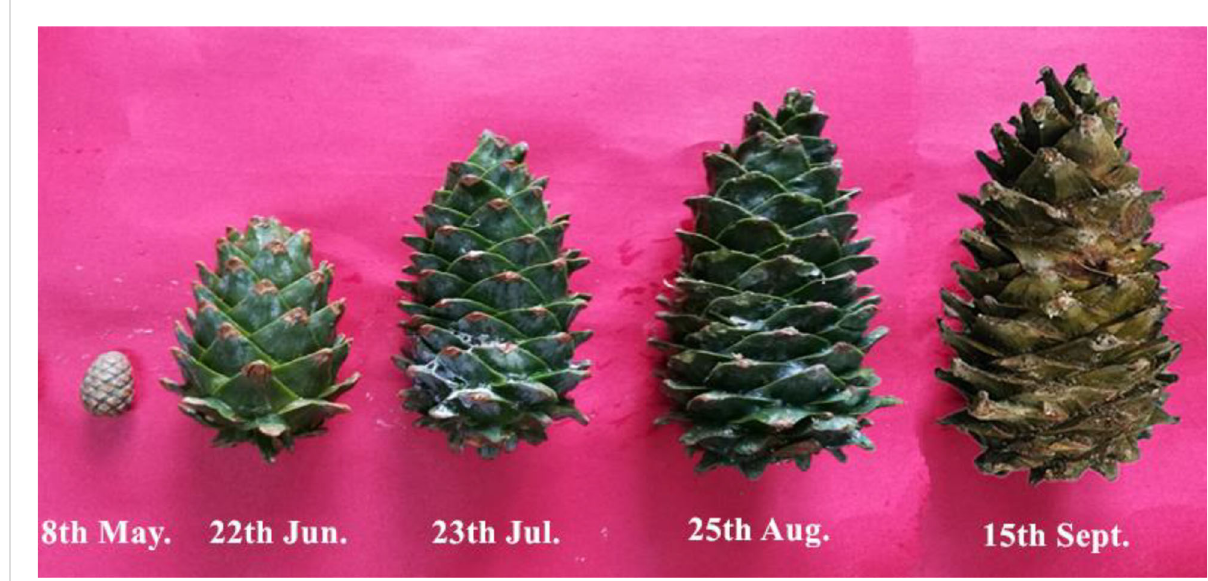
FIGURE 1 Female cones of Pinus koraiensis at different developmental stages. The numbers below each cone denote the sampling dates at May, June, July, August and September, corresponding to DOYs 128, 172, 204, 237 and 258,